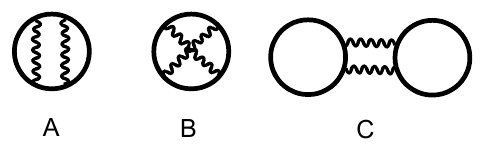
Figure 4 . 1PI diagrams contributing to the three-loop EHL.